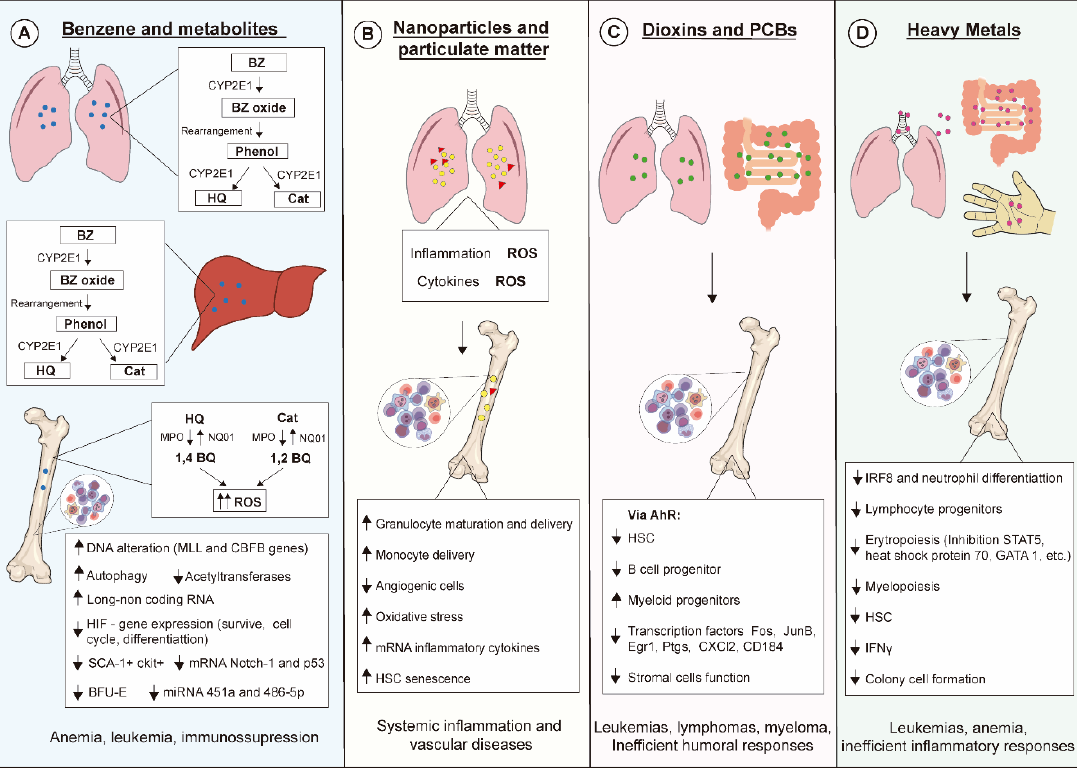
Figure 2. Molecular and cellular mechanisms linked to toxic e ff ects of environmental pollutants on hematopoiesis. ( A ) Benzene (BZ) is metabolized by CYP2E1 in liver and lung generating hydroquinone (HQ) and catechol (Cat), which are then transformed into benzoquinone (BQ). These metabolites exert myelotoxic actions upon several hematopoietic progenitors mainly by increasing levels of reactive oxygen species (ROSs), leading to oxidative DNA damage. ( B ) Nanoparticles and particulate matter induce generation of ROSs and secretion of inflammatory cytokines that a ff ect the behavior of several hematopoietic cell lineages. ( C ) Dioxins and PCBs bind to and activate the aryl hydrocarbon receptor (AhR) in mucosal tissues, modulating the hematopoietic stem cell (HSC) pool and triggering both immunosuppressive e ff ects and myelodysplastic and malignant abnormalities. ( D ) Heavy metals can enter the body via several contact routes, their toxic e ff ects being responsible for impairing inflammatory responses and triggering leukemias and